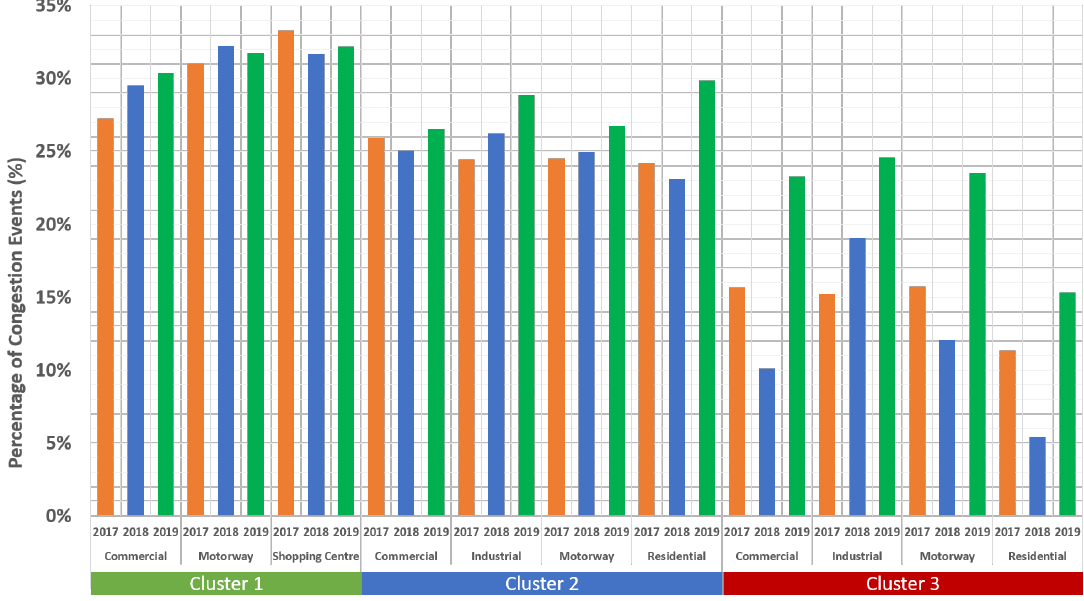
Figure 18. Network infrastructure usage and congestion events in